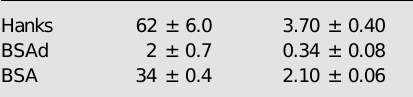
Table 1. Effect of fluid-phase denatured bovine serum albumin (BSAd) and native BSA on the interaction between macrophages and red cells covered with denatured BSA (E-BSAd).